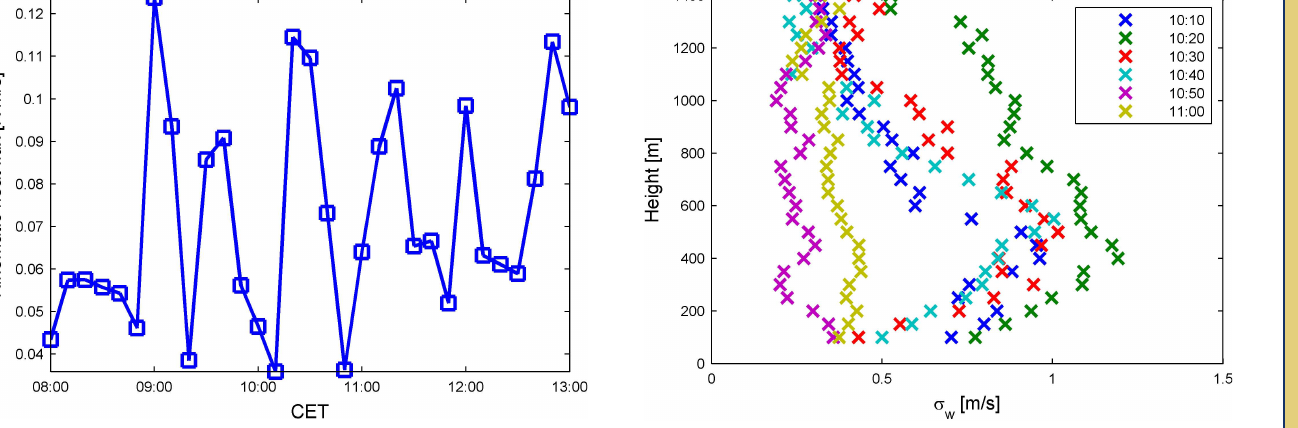
Figure 2. Measured kinematic heat flux at 10m. Figure 3. Profiles of σ w measured by the